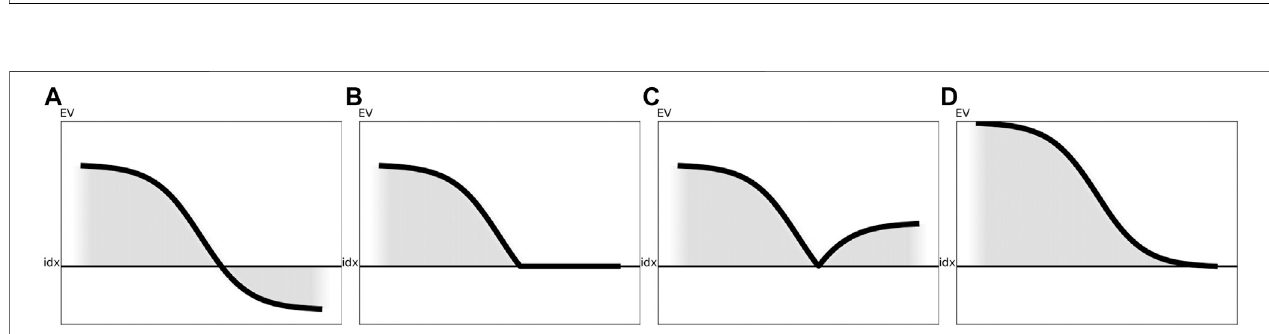
Frontiers in Applied Mathematics and Statistics |